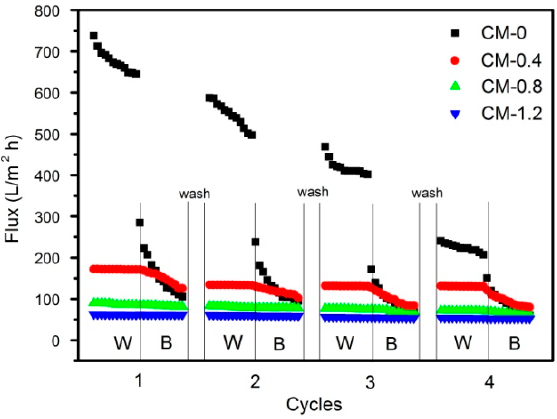
Figure 6. Flux of water and BSA solution for membranes. W: water flux filtration; B: BSA solution filtration.